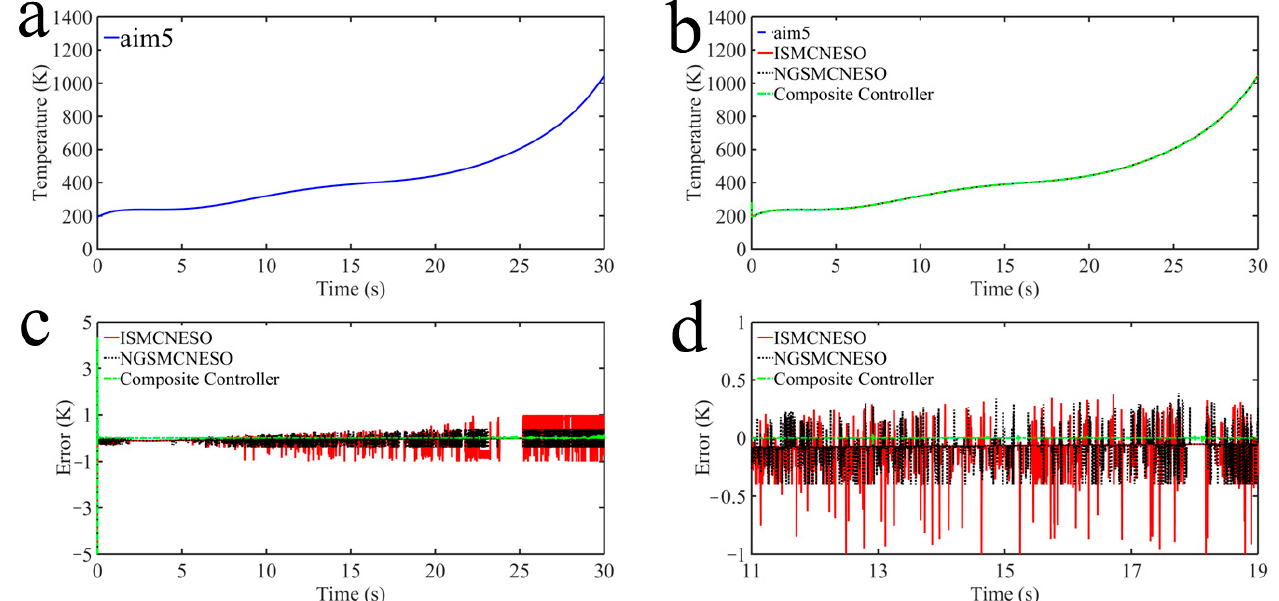
Figure 18. Simulation results: ( a ) the fitting curve of the reference temperature trajectory from Wall 1_45 mm; ( b ) the reference temperature tracking performance among ISMCNESO controller, NGSMCNESO controller, composite controller; ( c ) the tracking errors; ( d ) their partial enlarged figures in details.